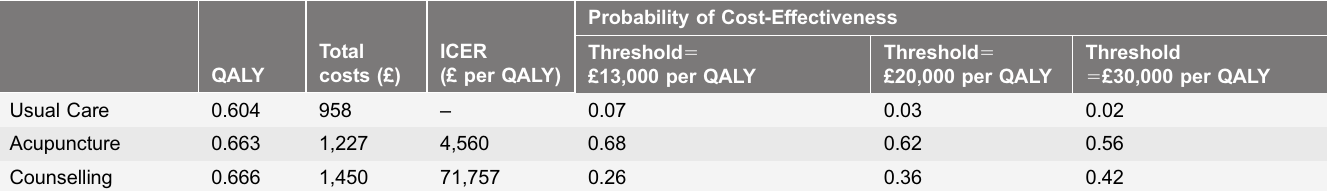
Table 5. Incremental cost-effectiveness of Usual Care, Acupuncture and Counselling.